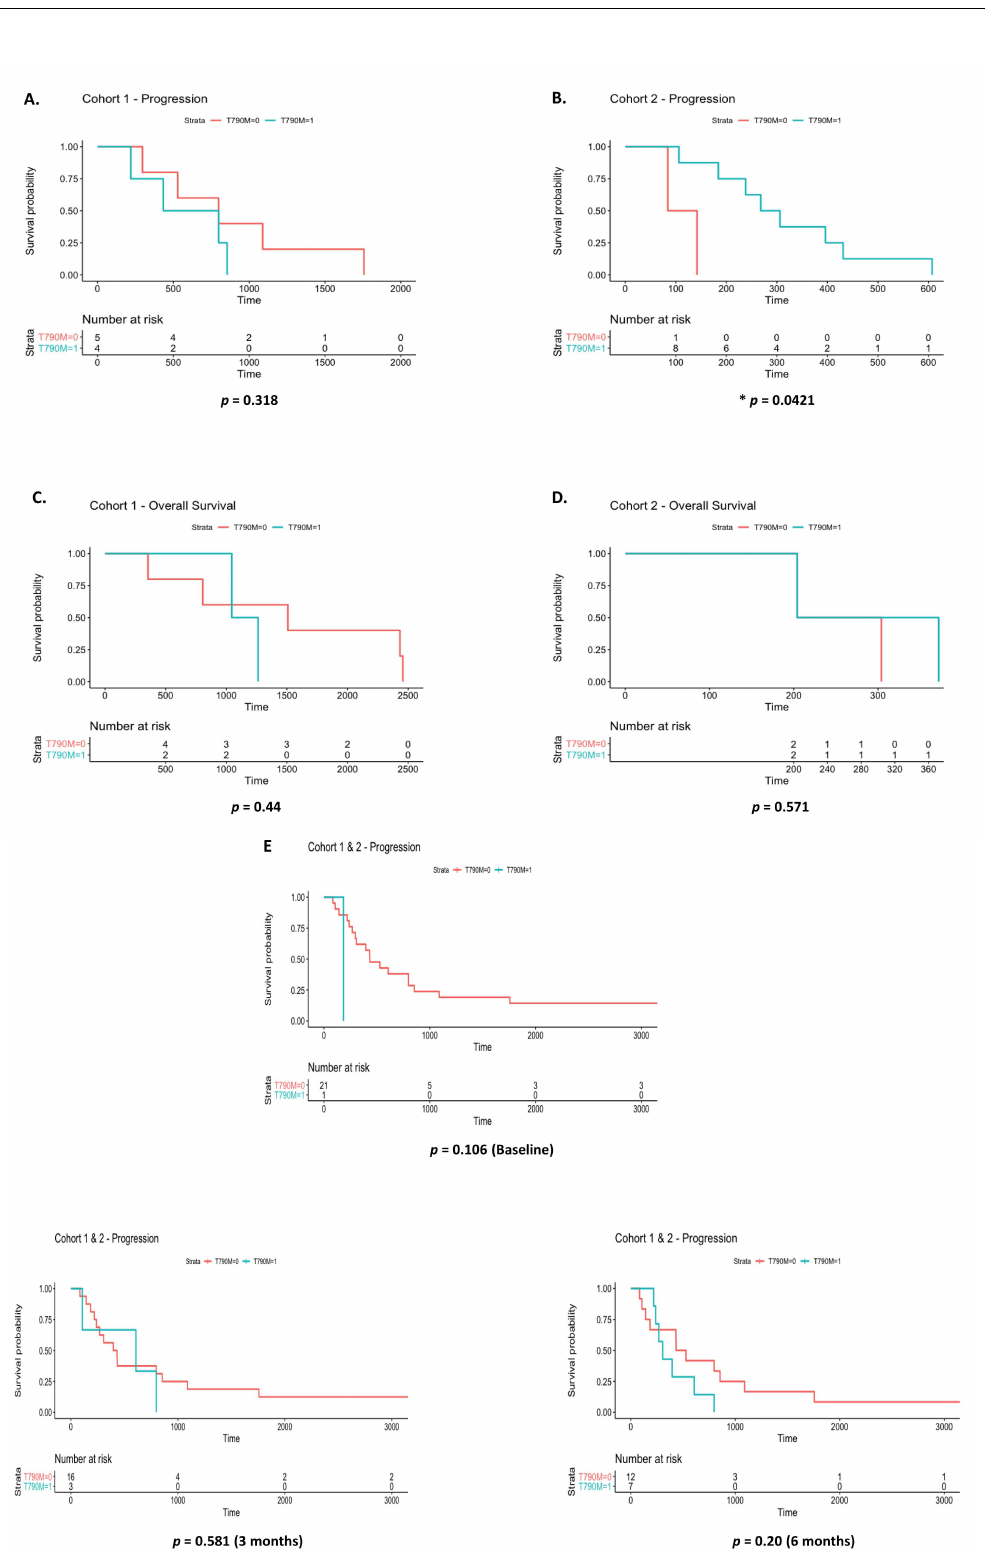
Figure 3. Time to progression and overall survival analysis relative to EGFR exon 20 p.T790M detection. The presence or absence of EGFR exon 20 p.T790M was correlated with disease progression ( A , B ) and overall survival ( C , D ) in cohort 1 and cohort 2 at baseline. Time to progression in both cohorts combined was examined at baseline, 3 months and 6 months ( E ). Univariate Cox proportional hazards analysis of time to progression and overall survival was used and Kaplan Meier survival plots represented (* p <